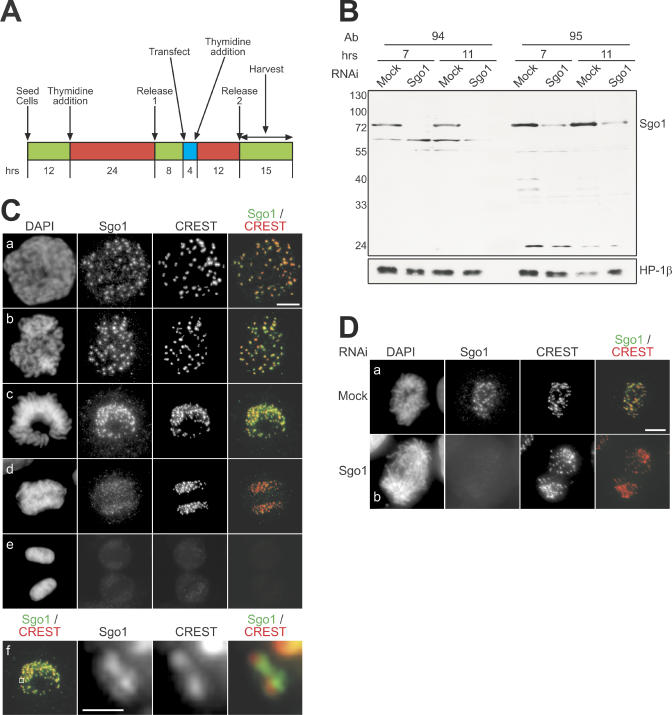
Centromeric Enrichment of Sgo1 in Mitosis(A) Schematic overview of cell synchronisation and transfection procedure.(B) Characterization of Sgo1 antibodies. Affinity-purified Sgo1 antibodies raised against two different regions of Sgo1 recognize the same 72-kDa protein by Western blotting. Synchronised HeLa cells were transfected with water (Mock) or Sgo1 siRNA. Cells were harvested 7 and 11 h after release from thymidine block, and chromatin fractions were resolved by SDS-PAGE and probed with antibodies 94 and 95. A major band at 72 kDa was detected by both antibodies, which disappeared or was greatly reduced upon Sgo1 knockdown. The blot was reprobed with HP-1β antibody as a loading control.(C) Localisation of Sgo1. Cells were costained for Sgo1 with antibody 94 (shown in green), and with CREST antiserum (shown in red). DNA was counterstained with DAPI. Five different stages of mitosis are shown: (a) prophase, (b) prometaphase, (c) metaphase, (d) anaphase, and (e) telophase. Bar = 10 μm. (f) A single pair of CREST labelled kinetochores are enlarged, showing two adjacent Sgo1 foci as commonly observed for late stage metaphases. Bar = 1 μm.(D) In situ immunofluorescence of (a) mock-treated or (b) Sgo1 siRNA-transfected HeLa cells, demonstrating the disappearance of the Sgo1 signal following siRNA treatment. The latter shows the typical in situ appearance of an Sgo1-depletion arrested cell (see Figures 3 and 6). Sgo1 was stained with antibody 94 (shown in green), and CREST is shown in red. DNA was counterstained with DAPI.